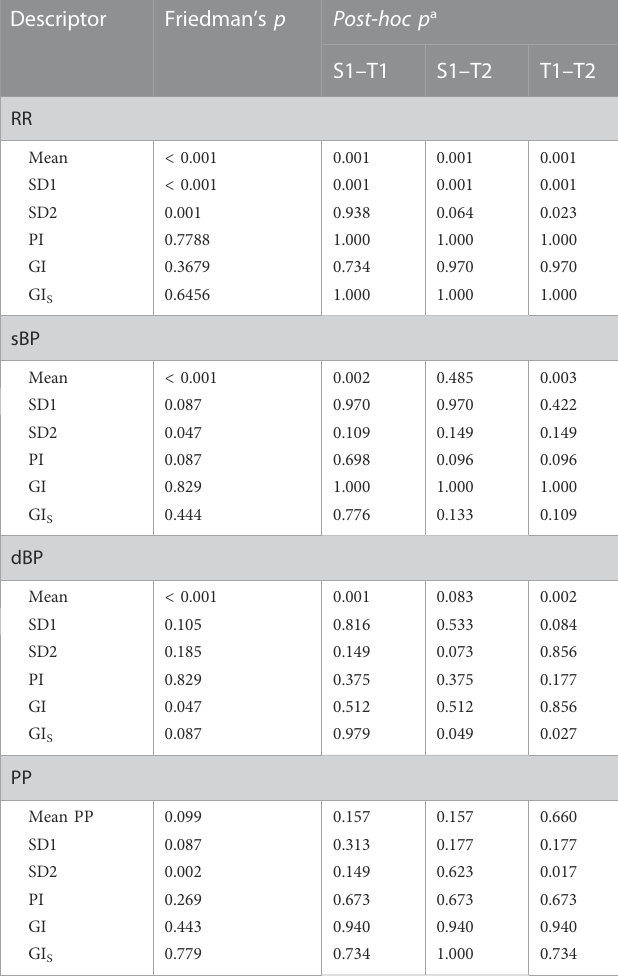
TABLE 3 Changes in variability and asymmetry of heartbeat interval (RR) and systolic, diastolic, and pulse blood pressure (sBP, dBP, and PP, respectively) recorded in the vasovagal female group. Comparison between the supine (S), initial part of tilt (T1), and pre-syncope phase (T2) of HUTT conducted on biosignal variability measures — beat-to-beat and slow variability (SD1 and SD2) and its asymmetry indices: Guzik ’ s Index (GI), slow-term Guzik ’ s Index (GI S ), and Porta ’ s Index